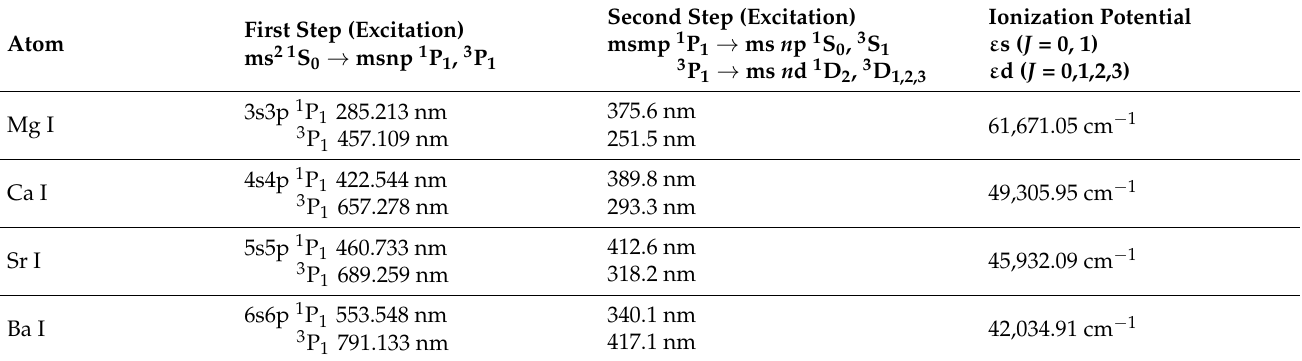
Table 4. Two-step excitation and ionization laser wavelengths for the Alkaline Earth Atoms.